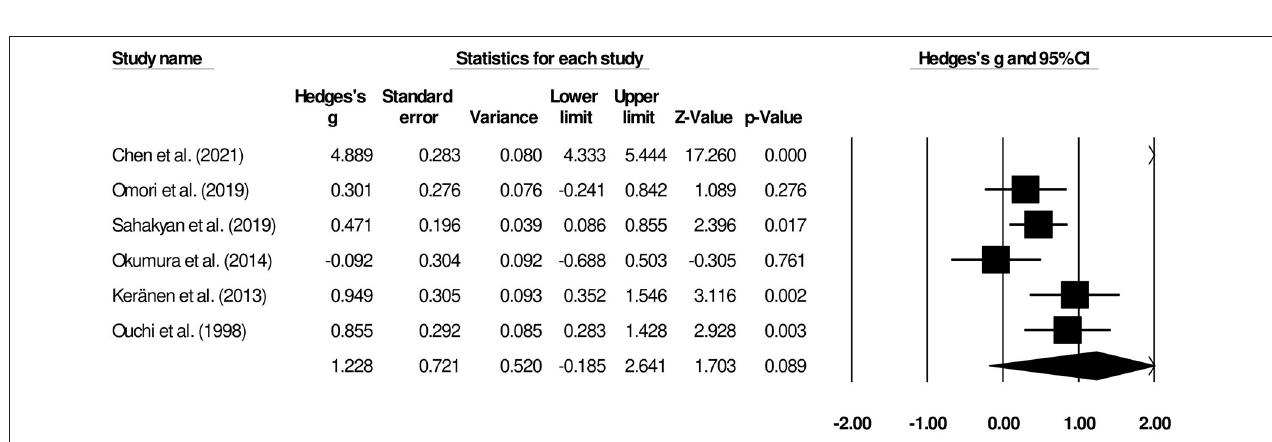
FIGURE 6 | Forest plot for studies comparing the overall survivals for patients undergoing gastrojejunostomy or palliative gastrectomy.